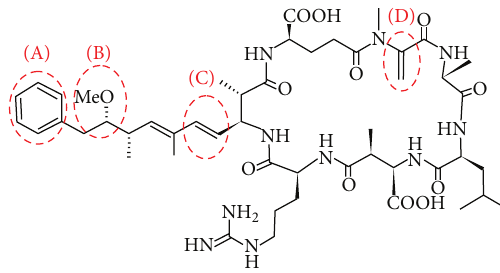
Figure 9: The molecular structure of microcystin-LR and the main attack sites ((A) benzene ring; (B) methoxy group; (C) conjugated double bond; (D) unsaturated double bond of MDHA) of hydroxyl radicals during photocatalytic reaction. ADDA: 3-amino-methoxy- 10-phenyl-2,6,8-trimethyl-deca-4,6-dienoic